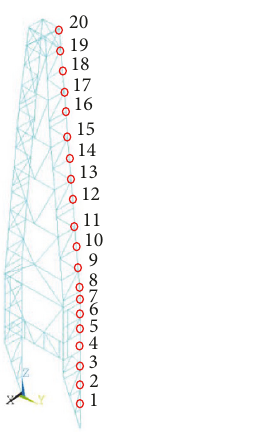
Figure 1: Finite-element model of the derrick steel structure.